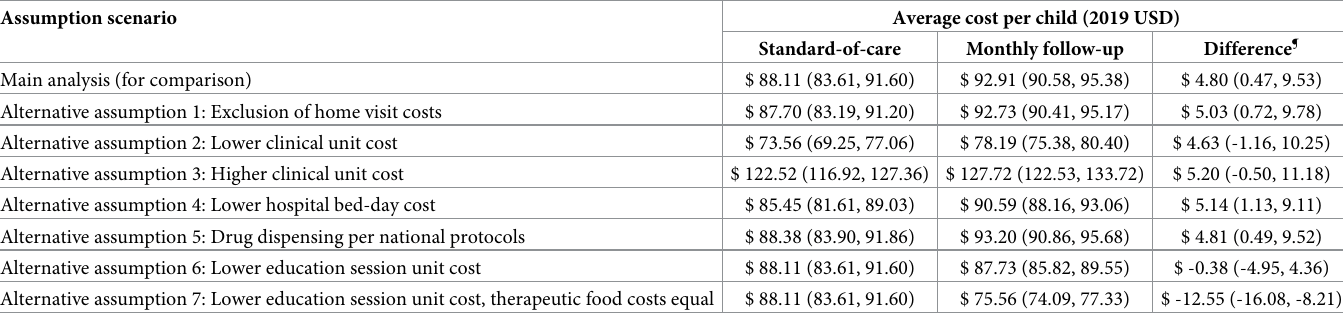
Table 3. Estimates of the societal cost per child under alternative analytic